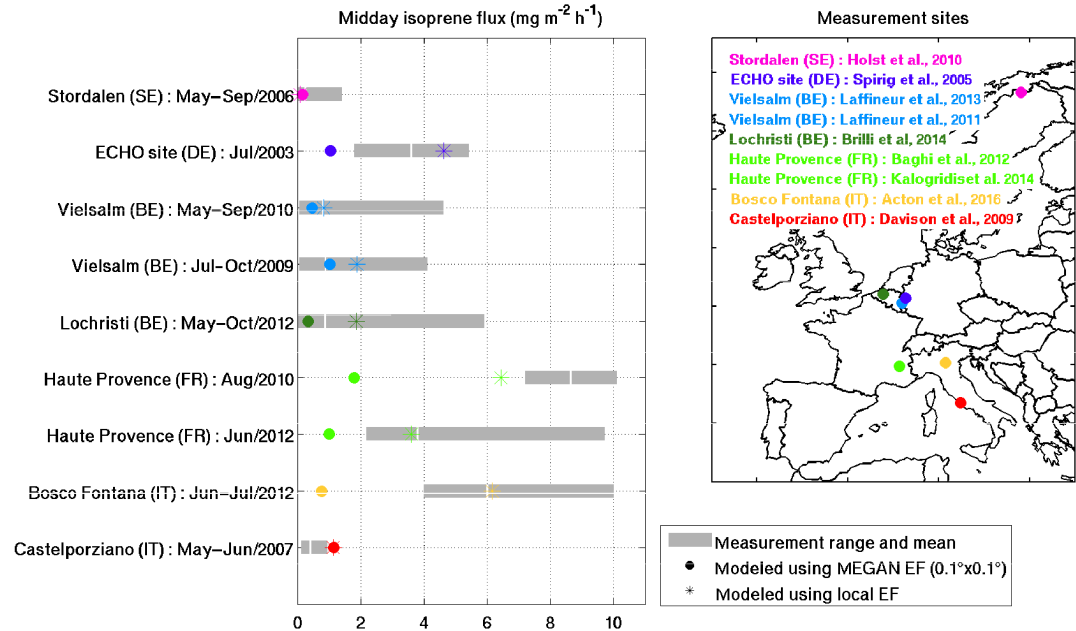
Figure 5. Modeled and measured isoprene midday fluxes from nine field campaigns over Europe. The circles indicate the monthly mean emissions modeled in the 0 . 1 ◦ × 0 . 1 ◦ cell including the measurement site using the emission factors of MEGAN–MOHYCAN. The stars denote the modeled fluxes using local emission factors (see text for details). The gray bands show the range of measured midday fluxes observed during the field campaigns. The average midday flux is shown in